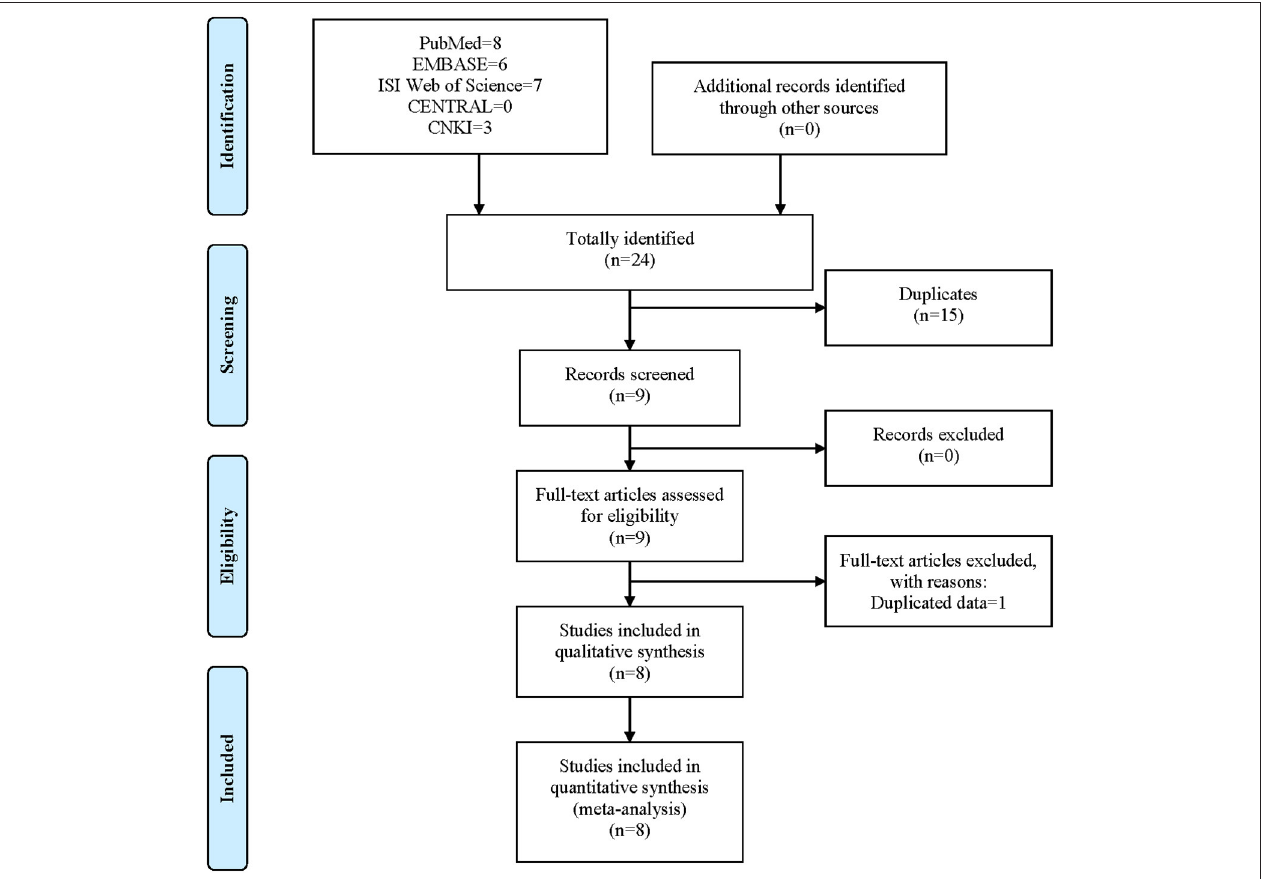
FIGURE 2 | Flow chart of the literature search and